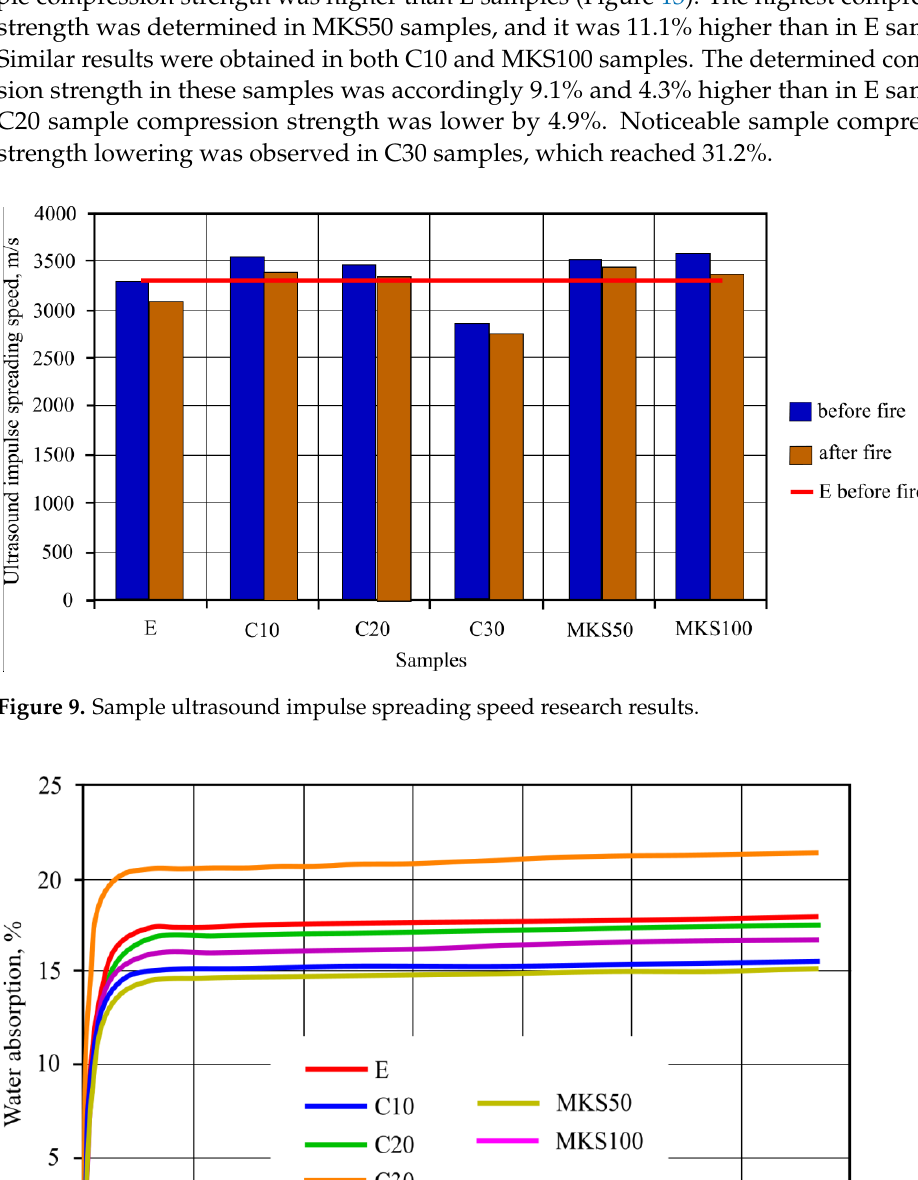
Figure 10. Sample water absorption results.